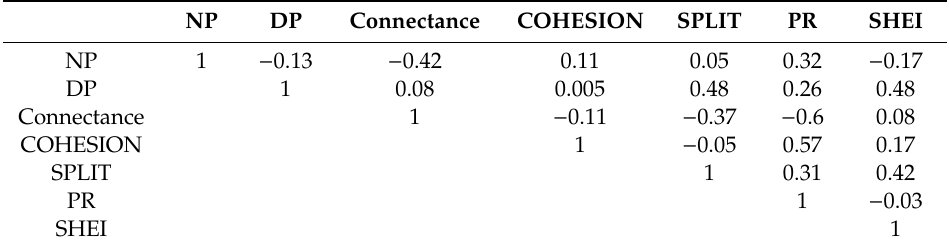
Table 3. The correlation coe ffi cients between seven pairs of landscape metrics. Seven landscape metrics were kept because their correlation coe ffi cients were less than | 0.6 |